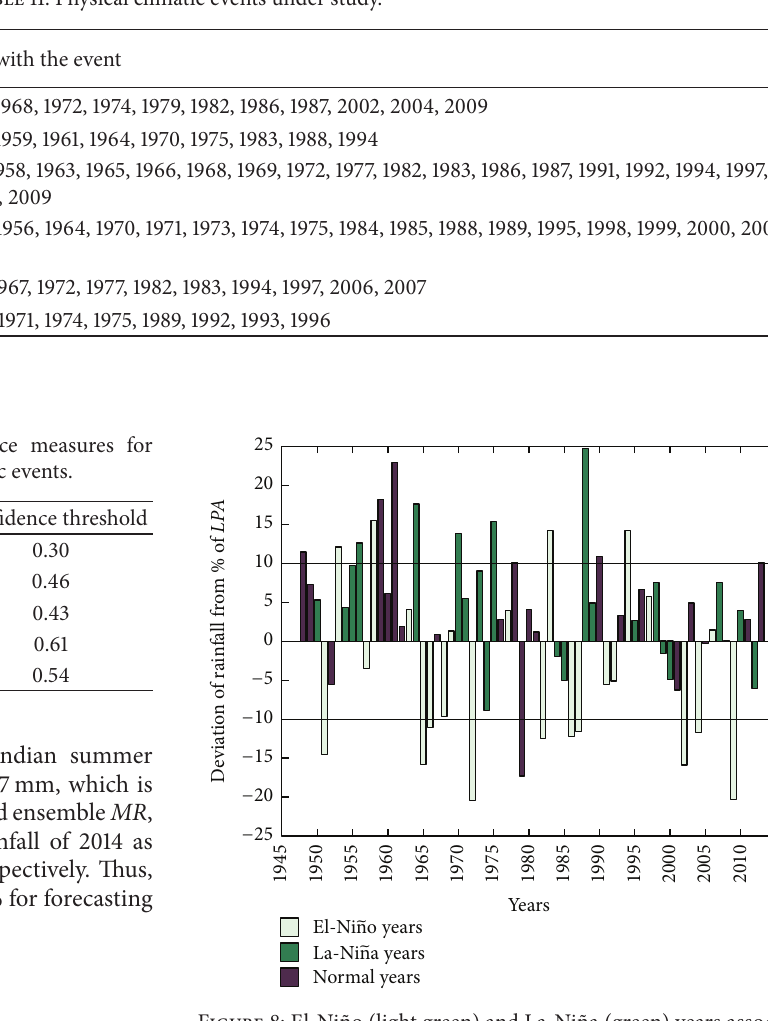
Table 11: Physical climatic events under study.